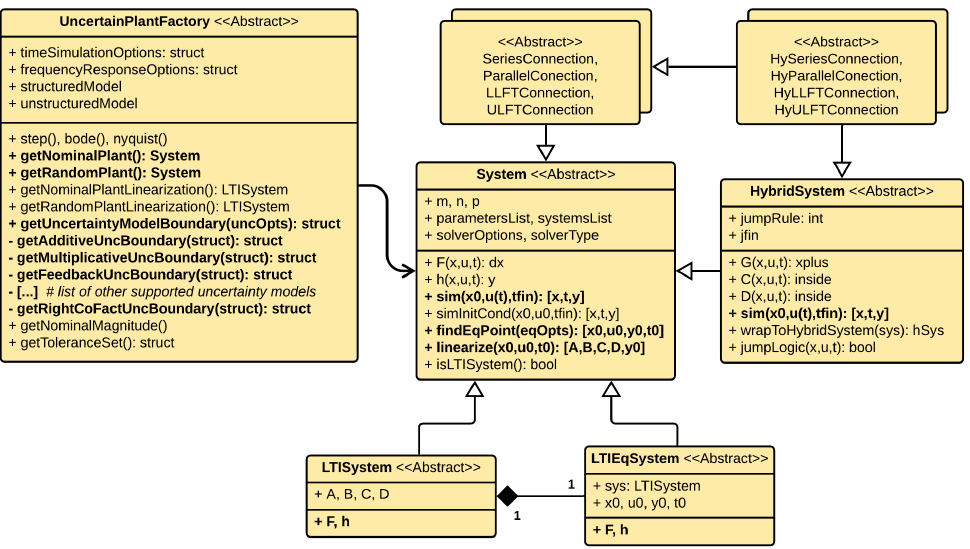
Figure 1. Class diagram for general-purpose nonlinear, LTI, linearized, and hybrid system imple- mentations, along with the uncertain plant factory class, interconnections, and main